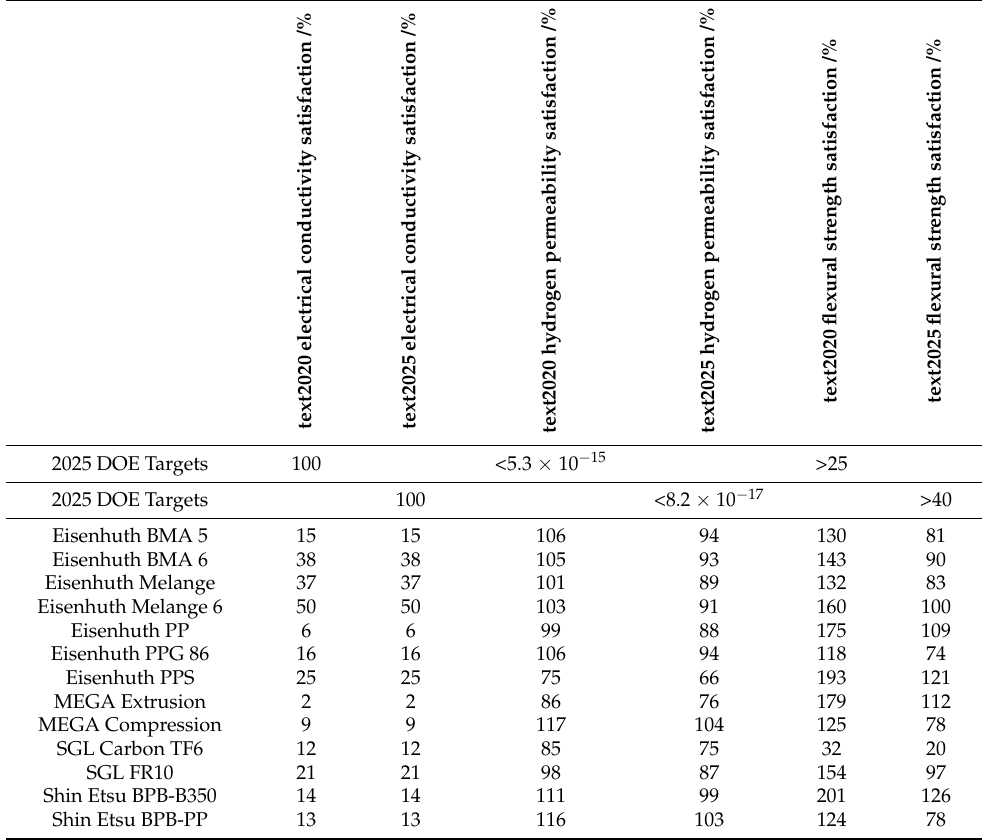
Table 4. Percent of satisfaction with the 2020 and 2025 DOE